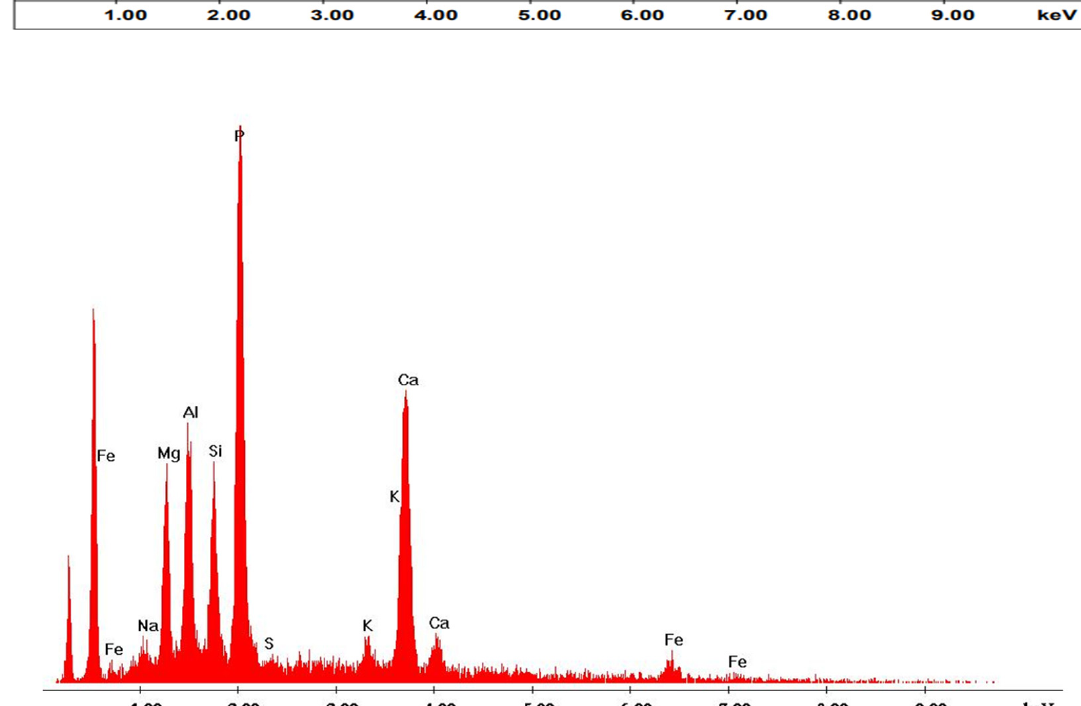
Figure 6. Volume distribution of individual particle fractions in fly ash. The composition, physical and chemical properties, and technique used to incinerate the ashes from sewage sludge make it similar to those of fly ashes obtained from coal combustion. The presence of the active oxides CaO, SiO 2 , Al 2 O 3 , and Fe 2 O 3 may have a positive effect on the hardening of mortars and concretes [63,64]. The greater presence of alumina—Al 2 O 3 , as well as calcium and sulphate ions compared to Portland cement contributes to the formation of calcium sulphaluminate (AFt) and calcium aluminate (AFm) hydrates [65,66]. The presence of SSA in concrete, and the AFm in it can increase its resistance to the harmful effects of chloride [66,67]. An additional benefit of using sludge ash is the ability to immobilize heavy metals [27,68]. 0510 15 20